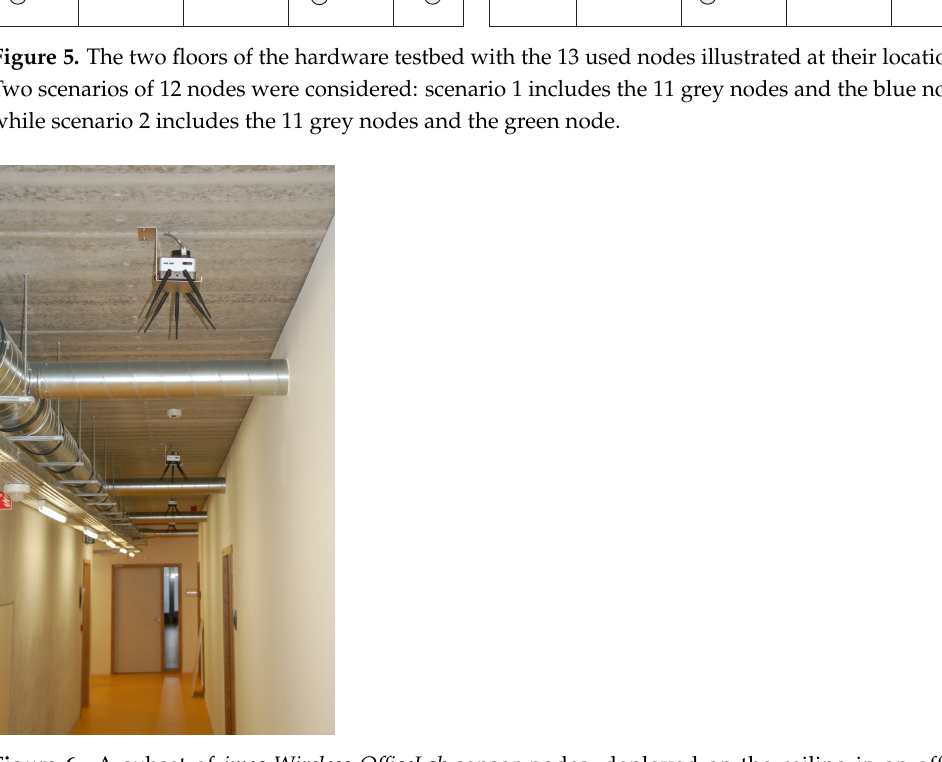
Figure 6. A subset of imec Wireless OfficeLab sensor nodes, deployed on the ceiling in an office environment spanning different floors of 805 m 2 , separated by reinforced